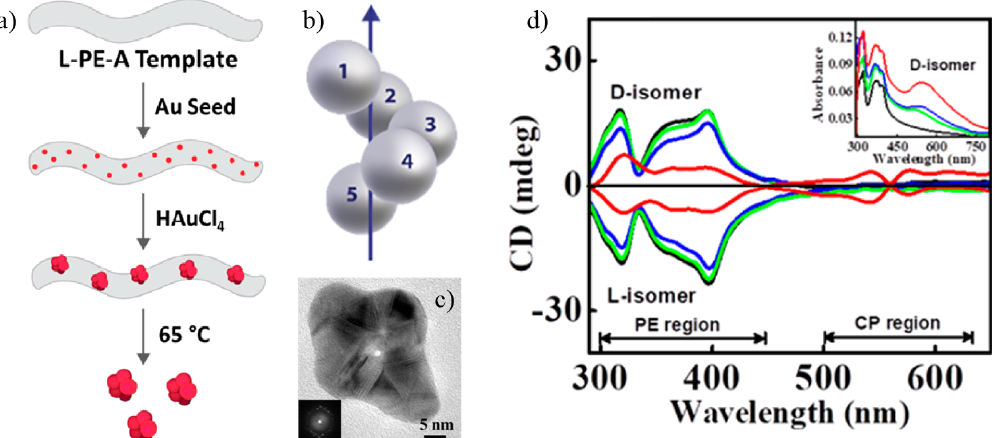
Figure 6. ( a ) Different steps for growing chiral nanoparticle arrangements along a polymer nanotube (used as a seed). ( b ) and ( c ) schematic illustration and TEM image of the resulting chiral Au nanostructure, respectively. ( d ) CD spectra for D- and L-isomer structures. The absorbance spectra are also shown in the inset. Reproduced with permission from ref. [78]. Copyright 2019 American Chemical